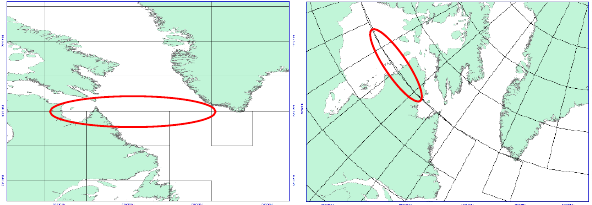
Figure 1 Demonstration of errors from projection schemes. (a) Geographic coordinate system; (b) UTM projection (a type of isometric projection). The red line circles the identical region in both geographic coordinate system and after UTM projection, to show errors in area-size after isometric